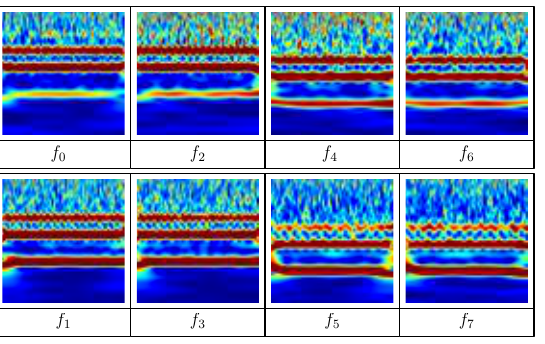
Figure 6. Wavelet images of different fault types, f 0 , . . . , f 7